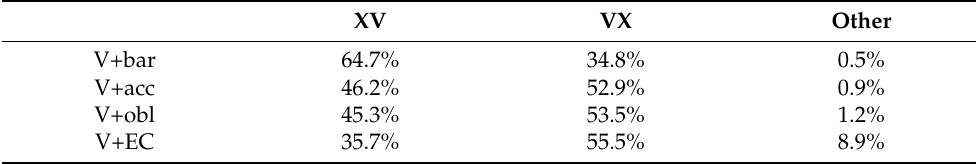
Table 2. V+X pairs in different word orders.